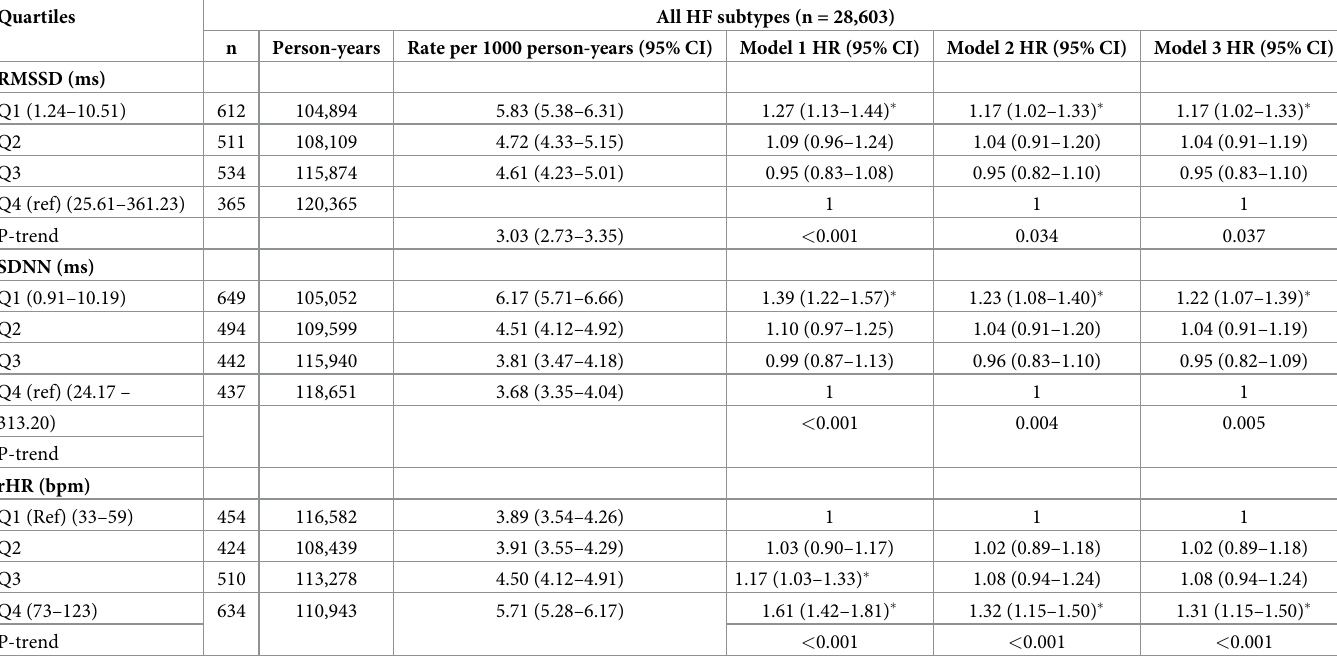
Model 1: adjusted for age and race Model 2: Model 1 + adjusted for smoking status, alcohol, education, physical activity, BMI, hyperlipidemia, hypertension, diabetes mellitus, LVH, beta-blocker use, calcium channel blocker use, hormone therapy use Model 3: model 2 + adjusted for time-varying incident CHD HF: heart failure; ms: millisecond; SDNN: standard deviation of normal-to-normal RR interval; RMSSD: root mean square of successive difference of RR intervals; rHR: resting heart rate � p <